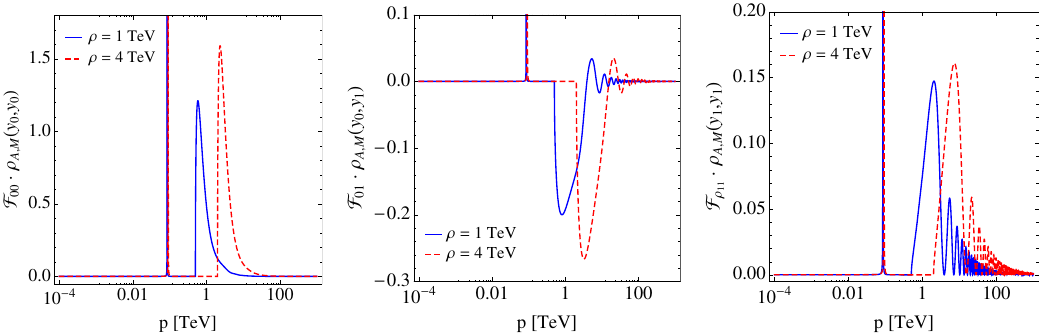
Figure 16 . Rescaled spectral functions F 00 · ρ A,M ( y 0 , y 0 ; p ) (left panel), F 01 · ρ A,M ( y 0 , y 1 ; p ) (middle panel) and F 11 · ρ A,M ( y 1 , y 1 ; p ) (right panel) for A = Z , m Z = 0 . 091 TeV. We display the results for ρ = 1 TeV (solid blue lines) and ρ = 4 TeV (dashed red lines). We have used A 1 = 35 in all panels and assume time-like momenta p 2 > 0